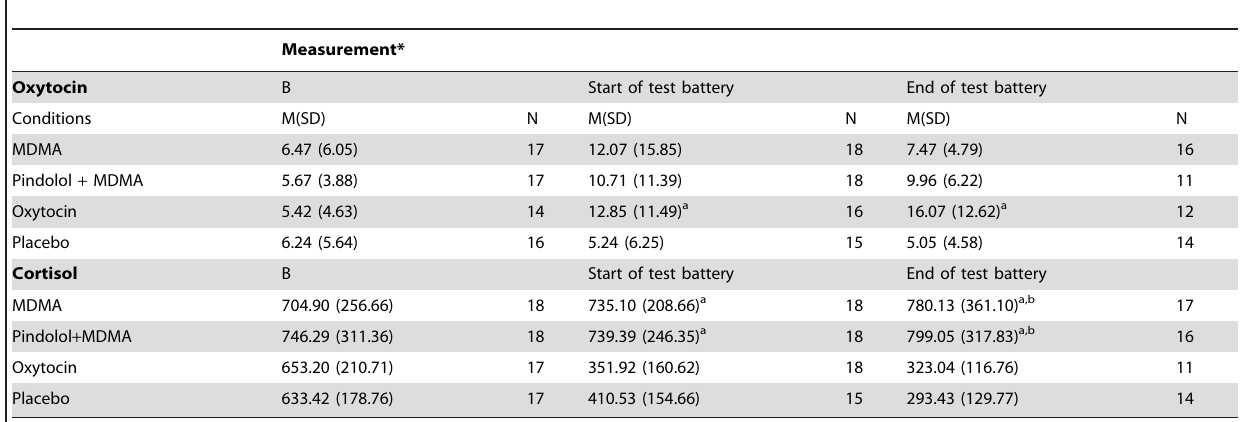
Table 4. Oxytocin (pg/mL) and cortisol (nM or nmol/L) serum concentrations * B= Baseline; Start of test battery=45 9